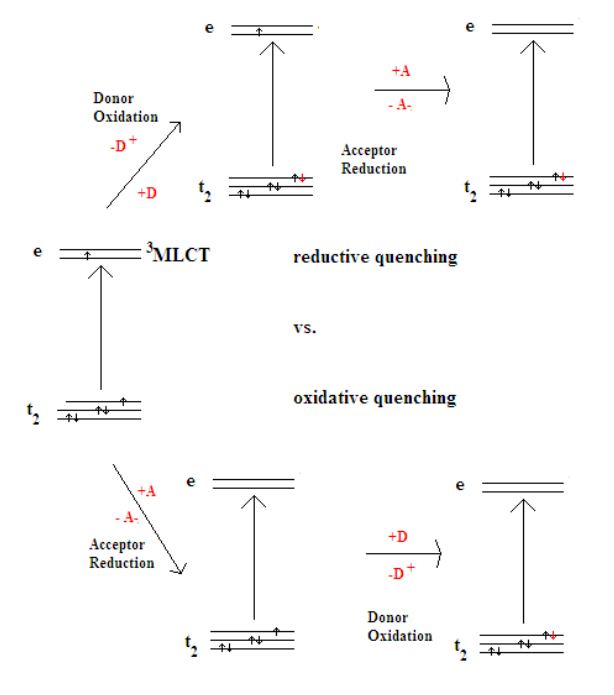
Figure 3. Schematic representation of the electronic aspects of the electron transfer during oxidation of the donor and the reduction of the acceptor